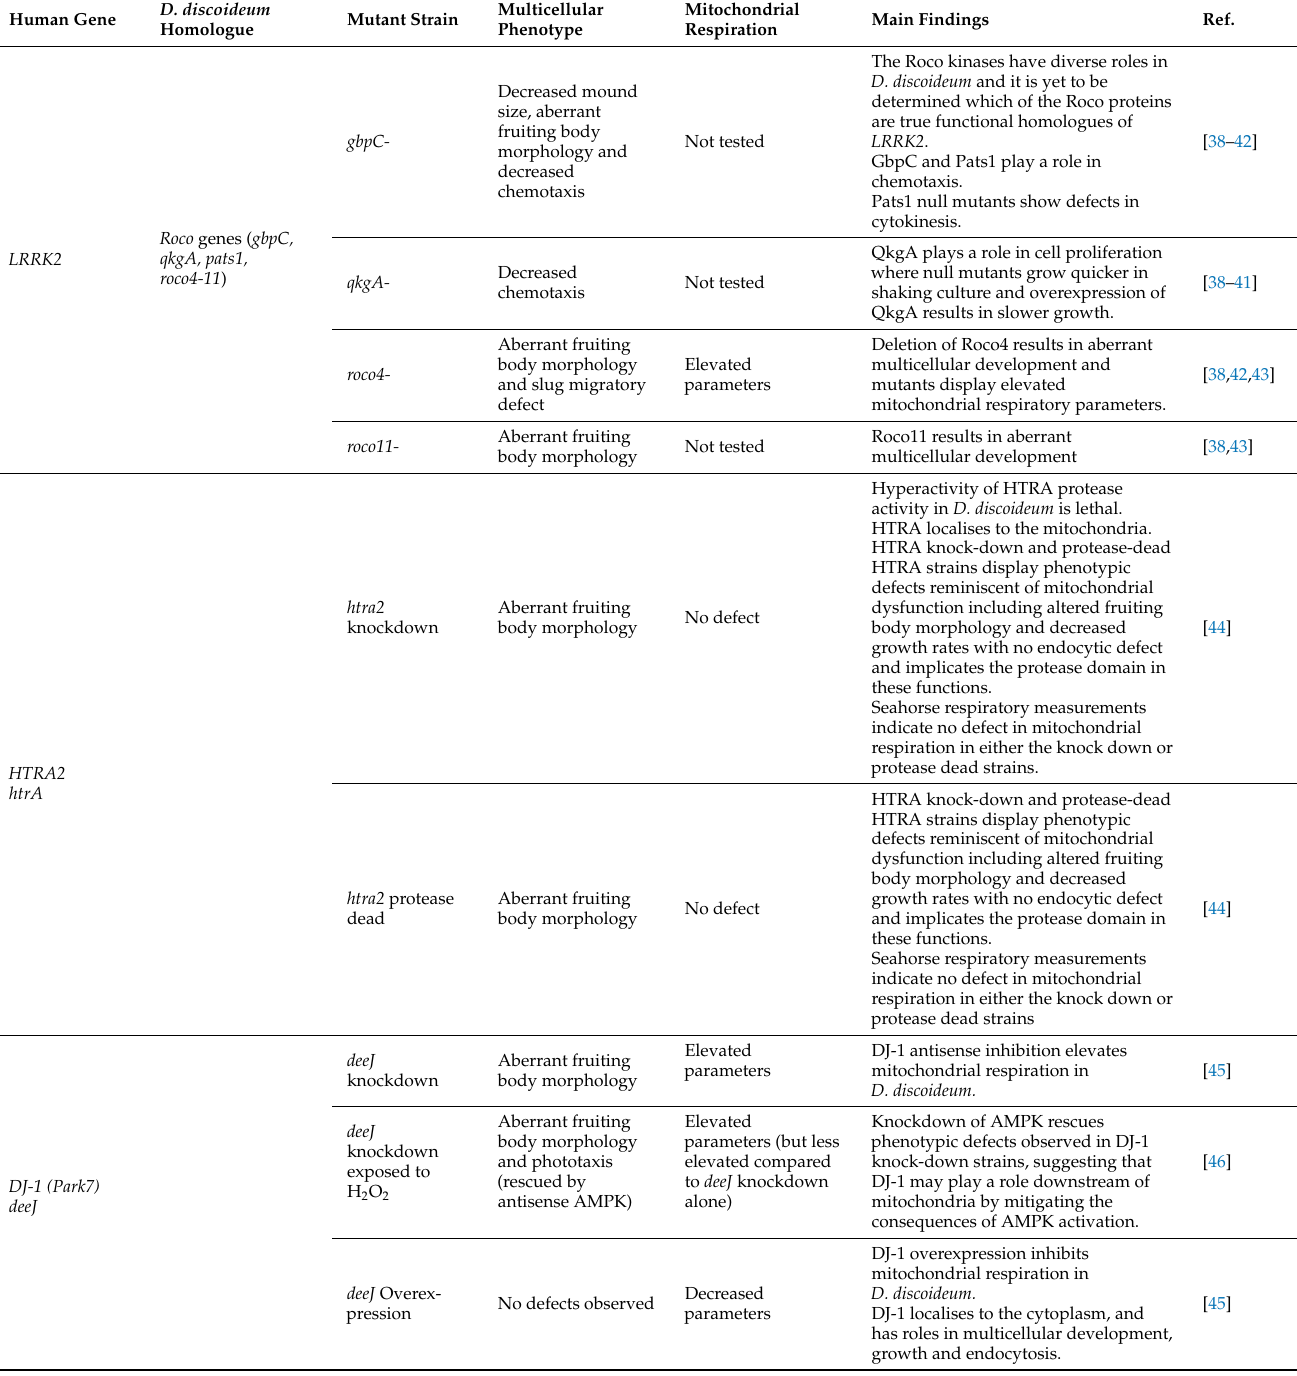
Table 1. PD-associated genes studied in D. discoideum